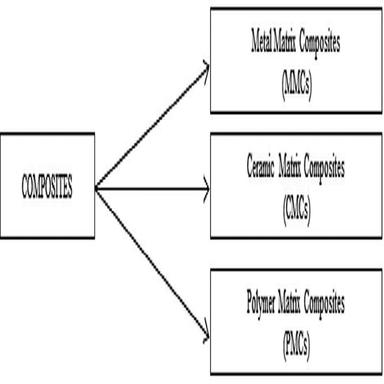
Classification of composite materials.